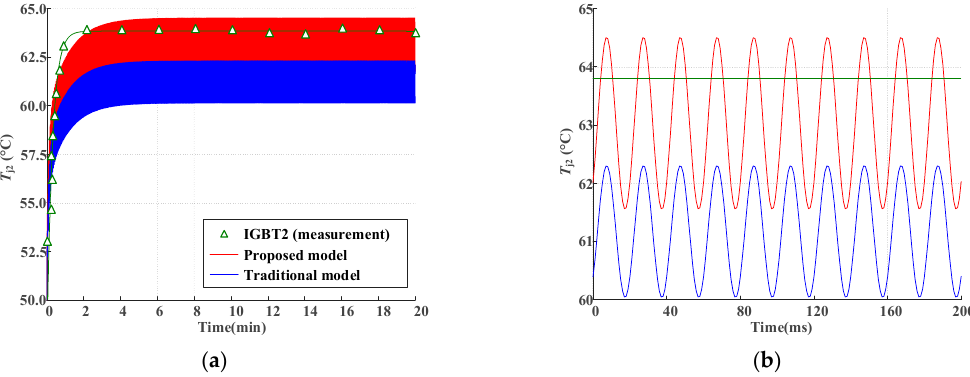
Figure 21. Comparison of junction temperature T j2 of IGBT2 between measurements and model estimation: ( a ) Comparison of temperature curves for 10 minutes; ( b ) model estimation of junction temperature for the last 200 ms.